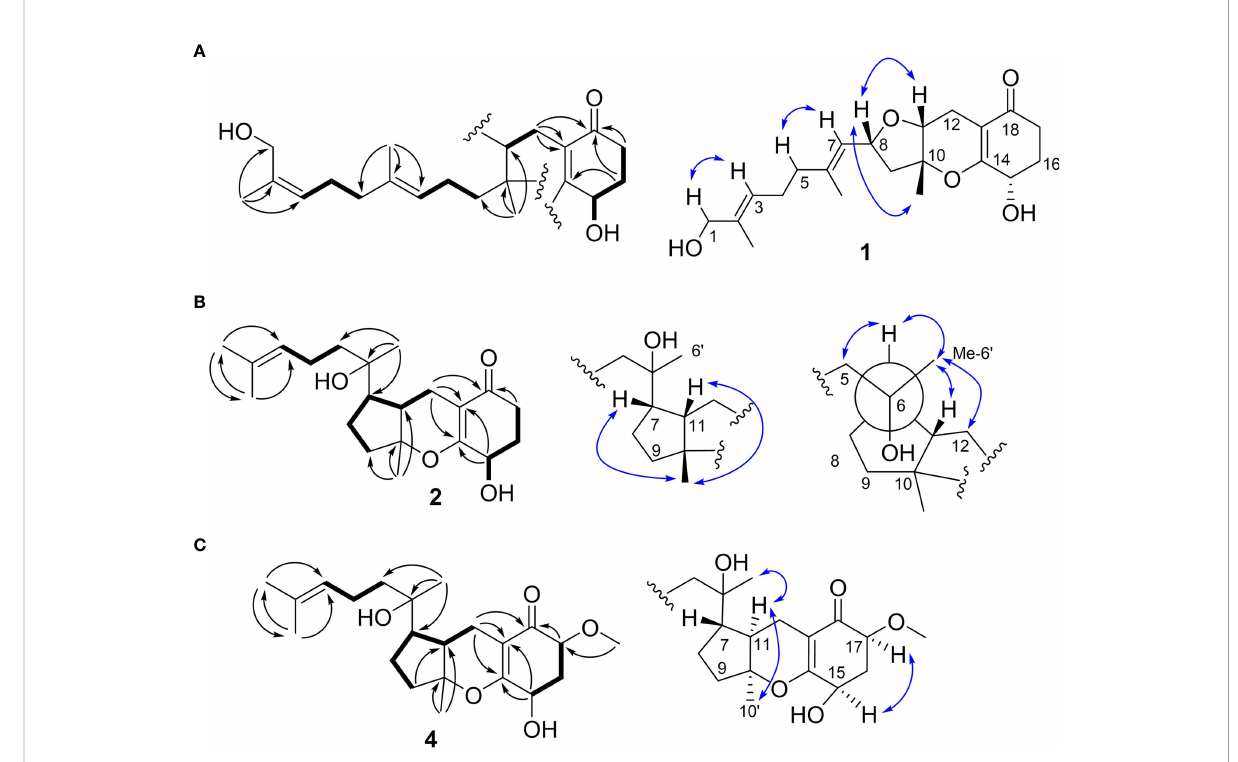
FIGURE 2 Key 2D correlations of compounds 1 (A) , 2 (B) and 4 (C)